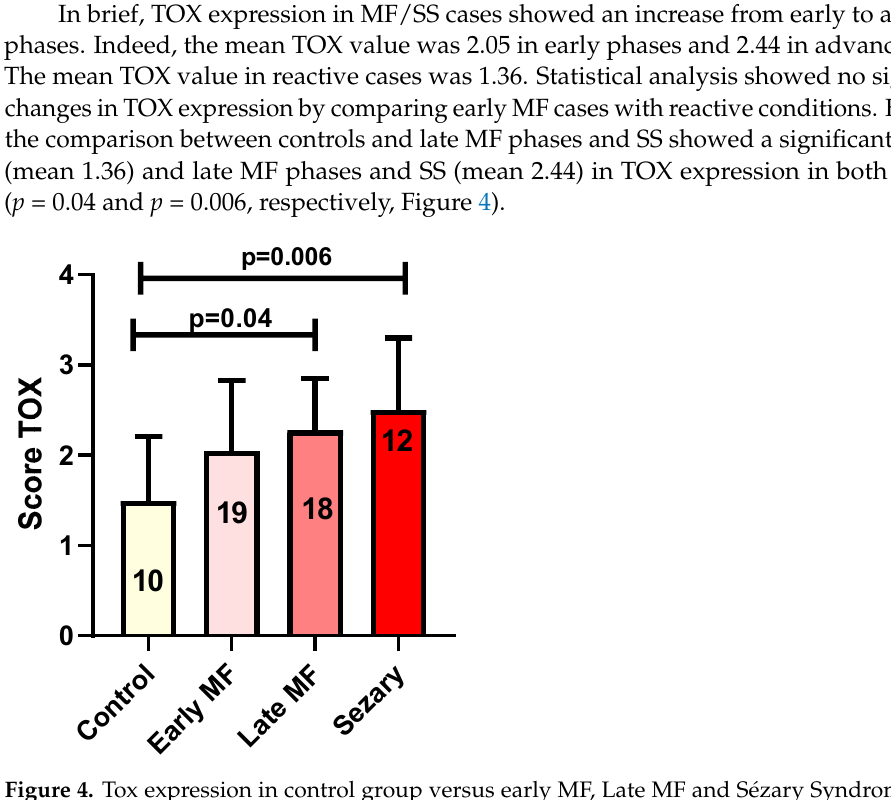
Figure 4. Tox expression in control group versus early MF, Late MF and Sézary Syndrome. In the columns: the number of biopsies evaluated in each group.